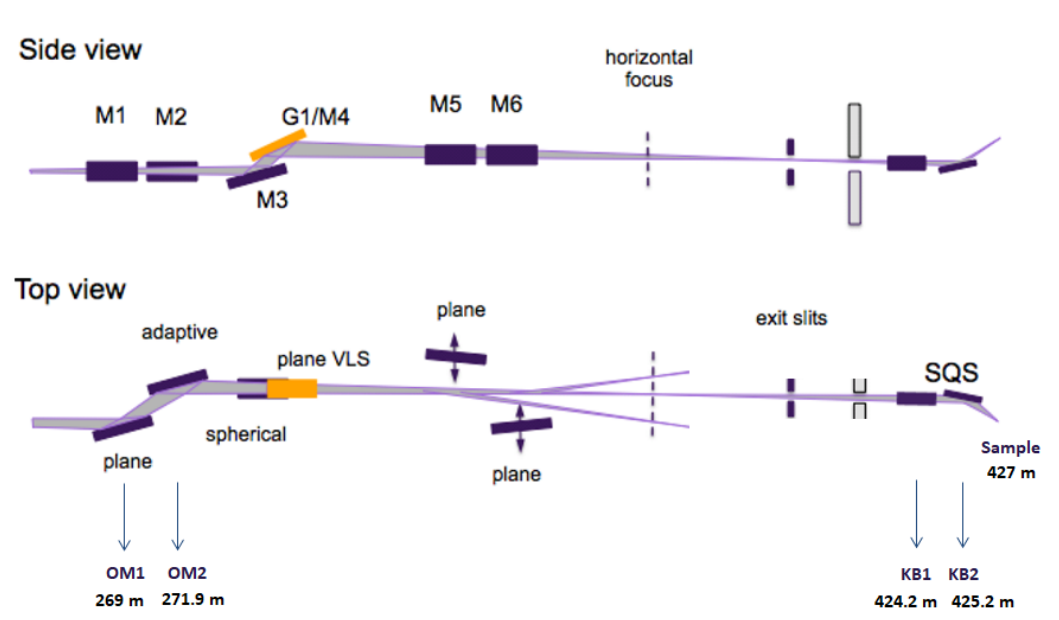
Figure 8. Optical elements relevant to SQS and their distances from the end of the SASE3 undulator. Four indicated optical elements are critical for beam transport and were simulated. Reprinted from